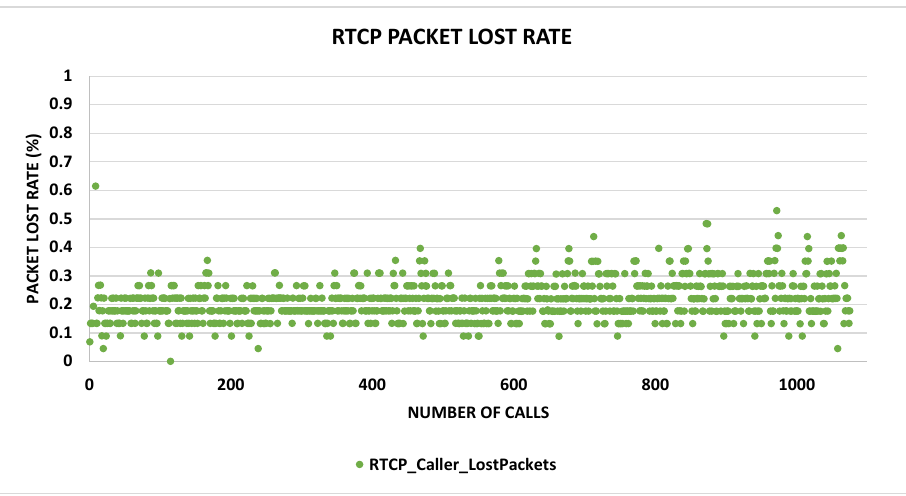
Figure 9. Evaluation of packet loss